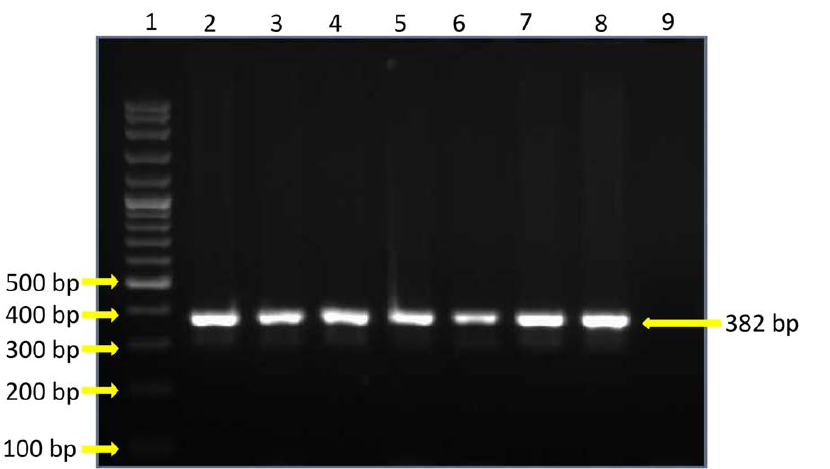
Figure 5. The electrophoretic banding patterns of the PCR products using the primers for the abaI gene. Lane 1–100bp DNA ladder, lane 2, 3, 4, 5, 6, 7, 8– amplicons from isolates S1, S11, S53, S54, S93, S102 and S117 respectively, lane 9– Negative control.